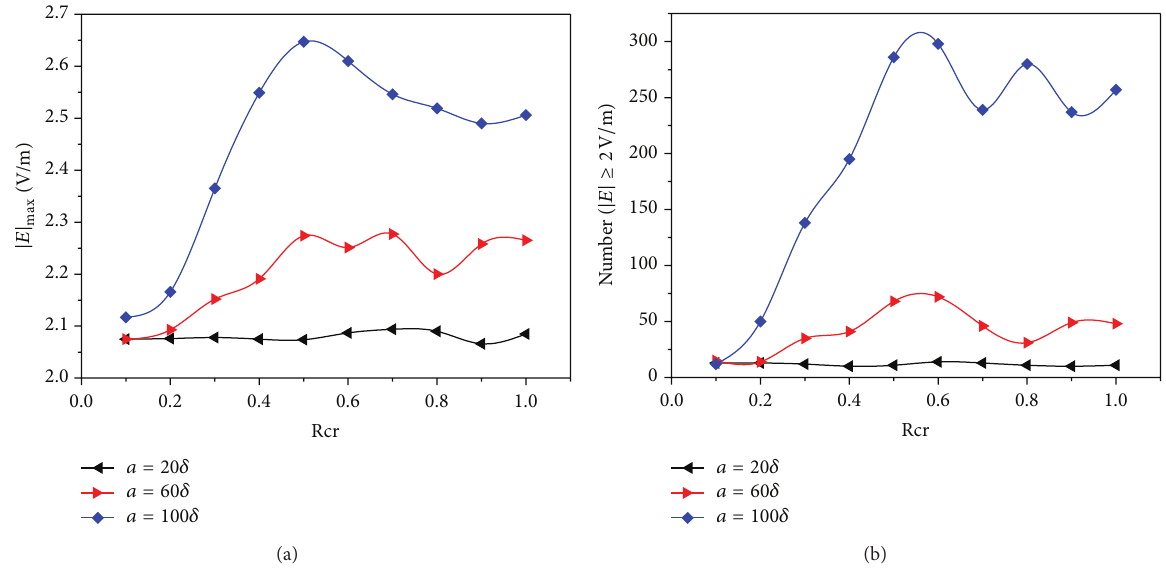
Figure 5: (a) |𝐸| max and (b) the number of high-intensity spots as the function of Rcr .